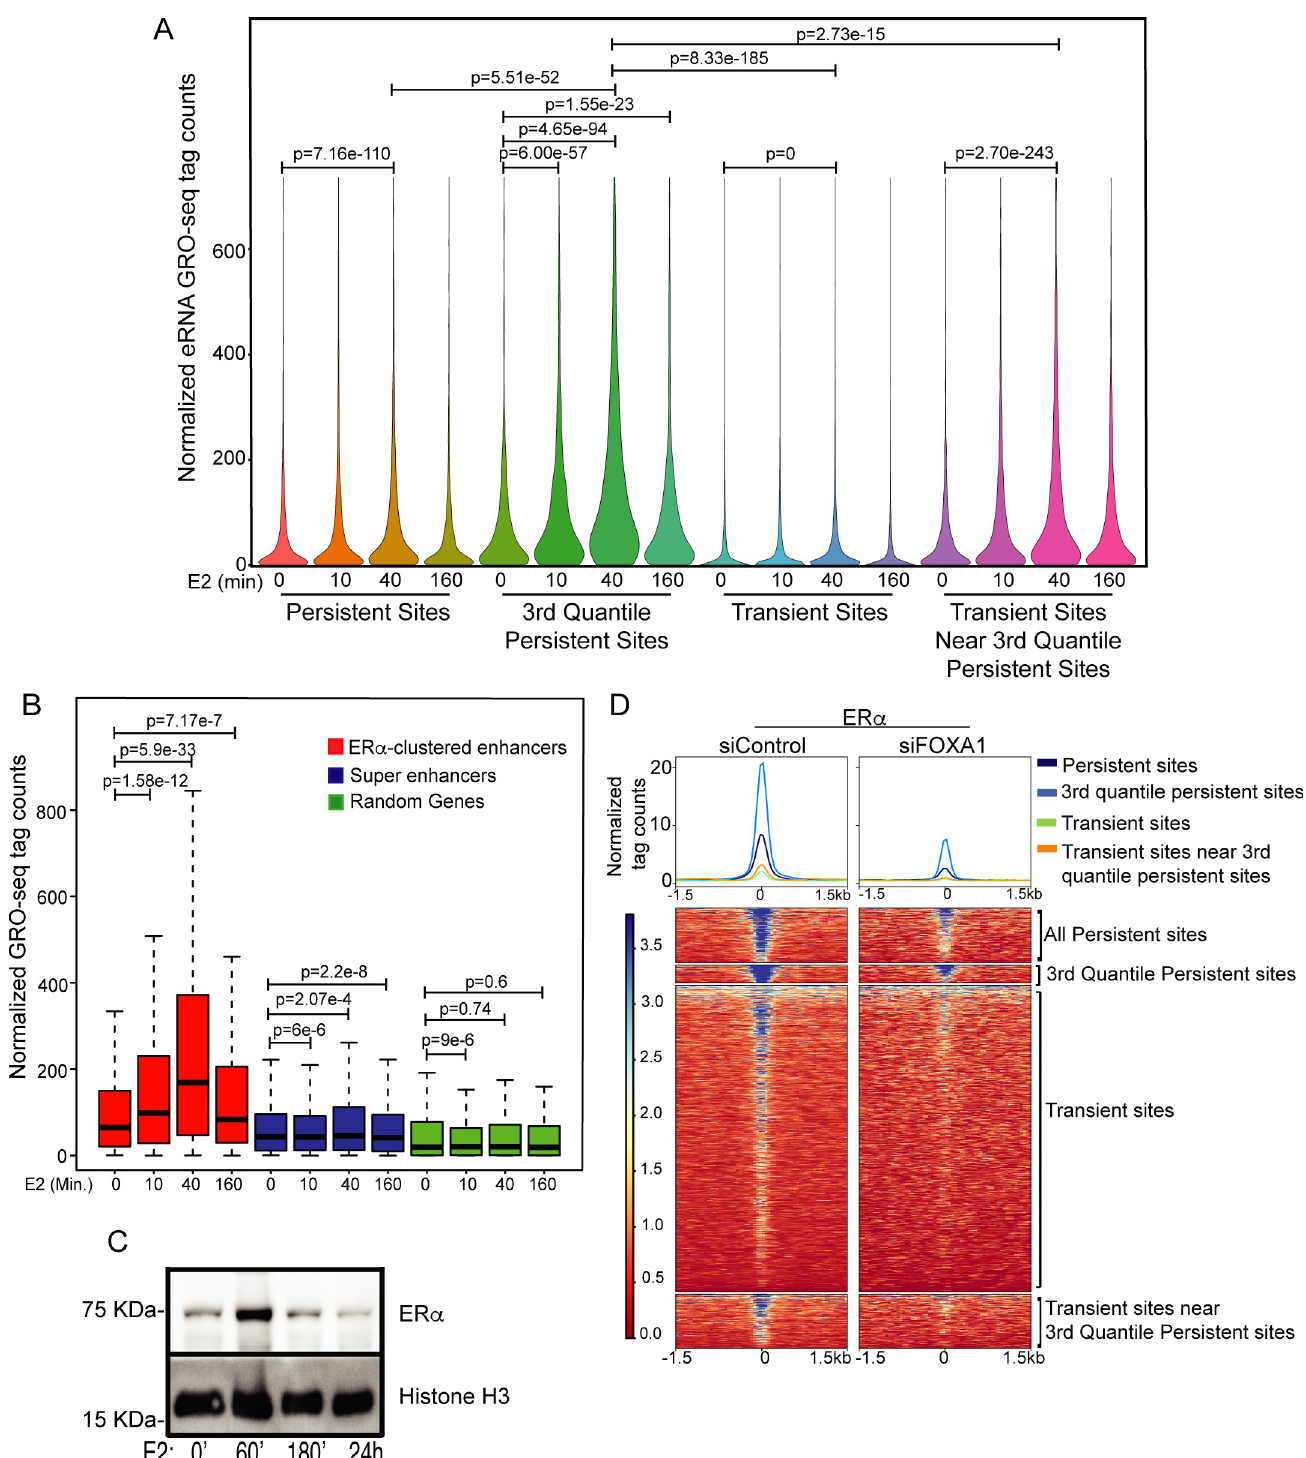
Fig 7. Emergence of ER α LDEC is correlated with robust target gene expression. (A) Combined eRNA levels from minus and plus strand show a robust increase in transcription at persistent sites at 40’ post-E2, much more so for the 3 rd quantile persistent sites. This is also true to a much smaller extent for transient sites near persistent sites, but not for distal transient sites that are not a part of LDECs. eRNA expression drops to basal level at all sites at 160’, except the strongest persistent sites still show relatively higher levels of eRNAs. (B) Expression of genes closer to all LDEC, H3K27ac super-enhancers and 300 random genes at 0’, 10’, 40’, and 160’ post-E2. (C) Chromatin-bound fractions of ER α at 0, 60’, 180’, and 24hr post-E2 shows the drop in ER α chromatin bound fraction at 180’. (D) Heatmaps